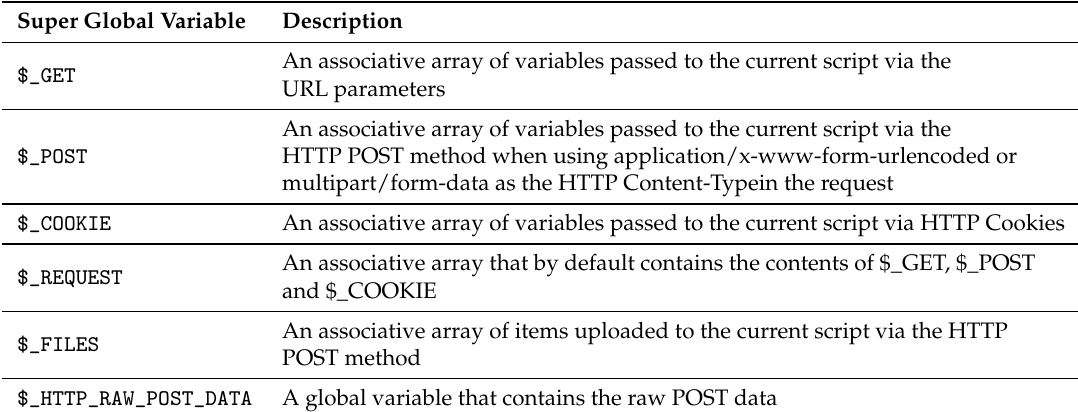
Table 2. Common mode of receiving inputs by